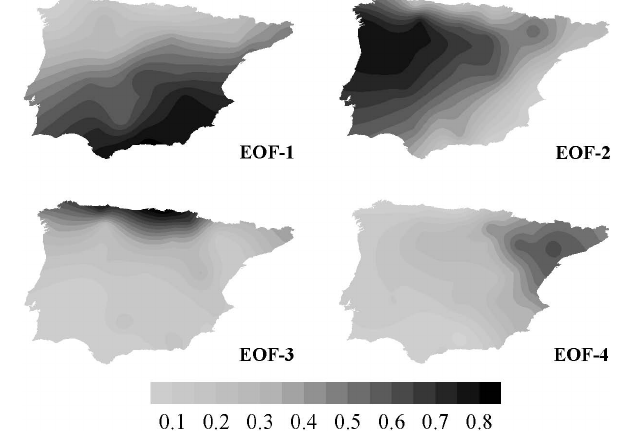
Fig. 4. First four rotated EOF obtained from the PCA applied to the estimated TCC monthly anomaly series over the 1913–2010 period. The maps show the isopleths of the loadings of the